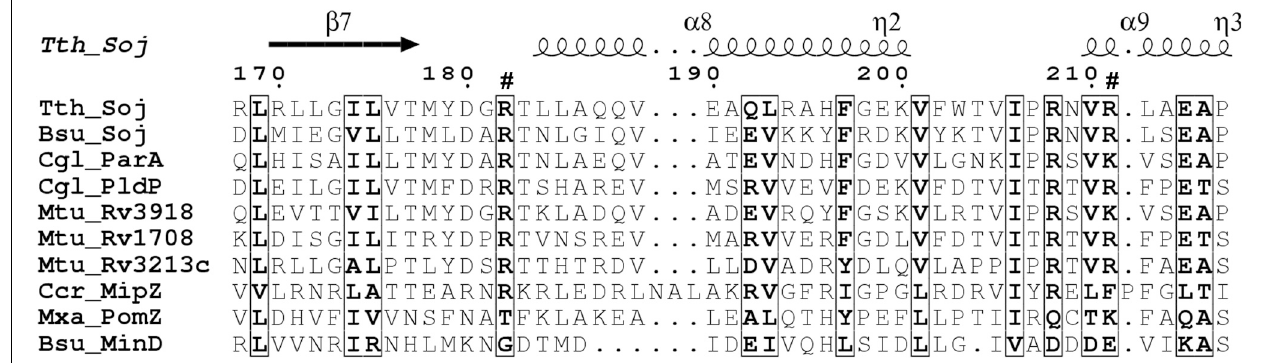
et al., 2003). Note that C. glutamicum ParA and PldP have the conserved positive charges (arrows) identified for DNA-binding in B. subtilis , while MinD lacks positive charges at these sites. Bsu, B. subtilis ; Ccr, C. crescentus ; Cgl, C. glutamicum; Mtu, M. tuberculosis ; Mxa, M. xanthus ; Tth, T. thermophilus .